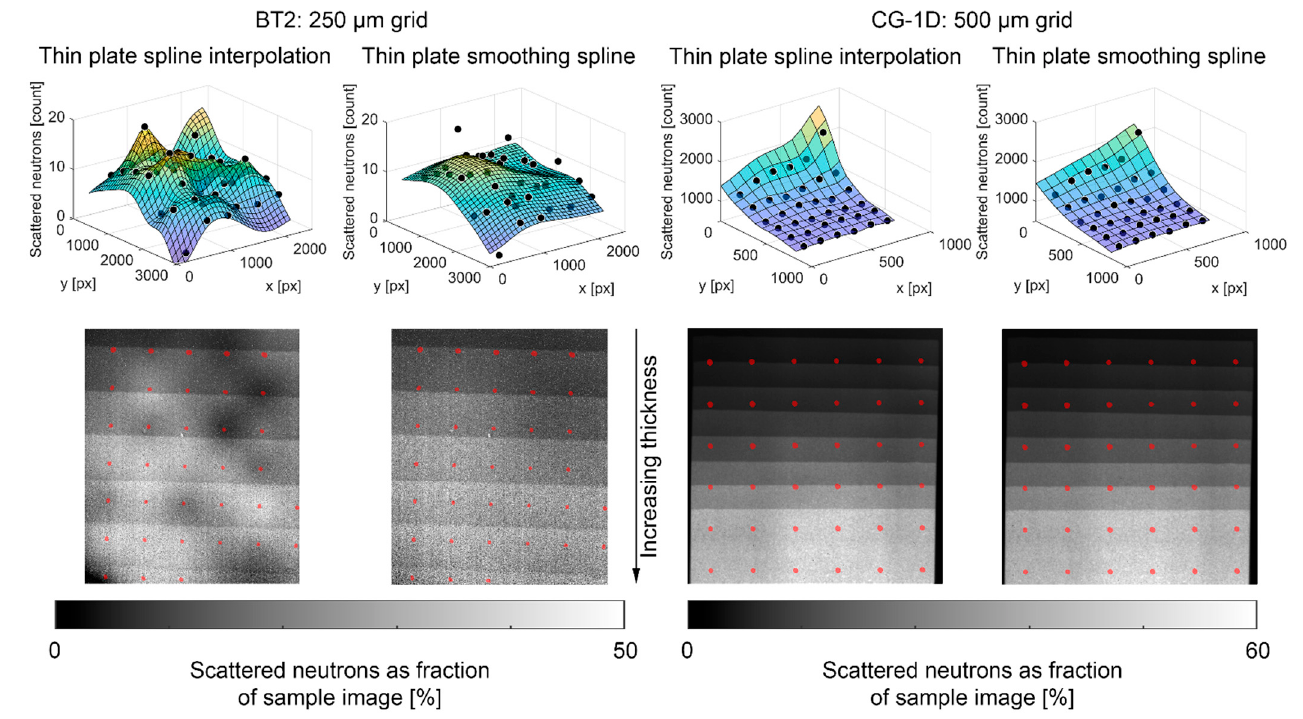
Figure 9. Comparison of scattering interpolation methods with PMMA step wedge. Surface plots compare interpolation methods to the measured scattering data. Black and white images show interpolated scattering as a fraction of the measured sample image. Overlaid red dots indicate locations of BBs. Table 3. Polynomial coefficients for beam hardening correction, p ( x ) = ∑ n